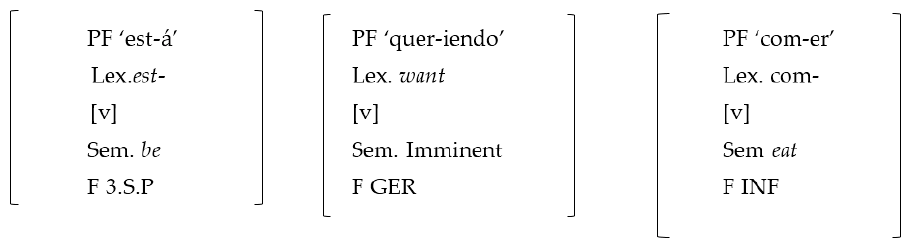
Figure 5. Alignment for está queriendo comer in Spanish.